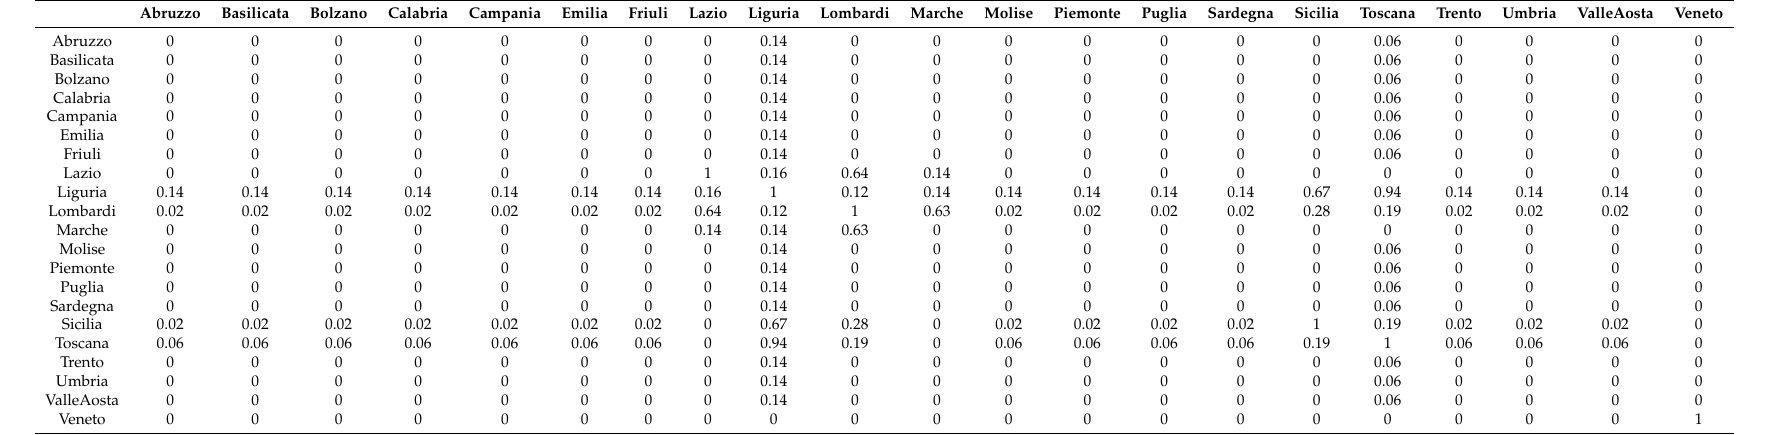
Table A38. Similarity values of Discharged/Healed network in the first